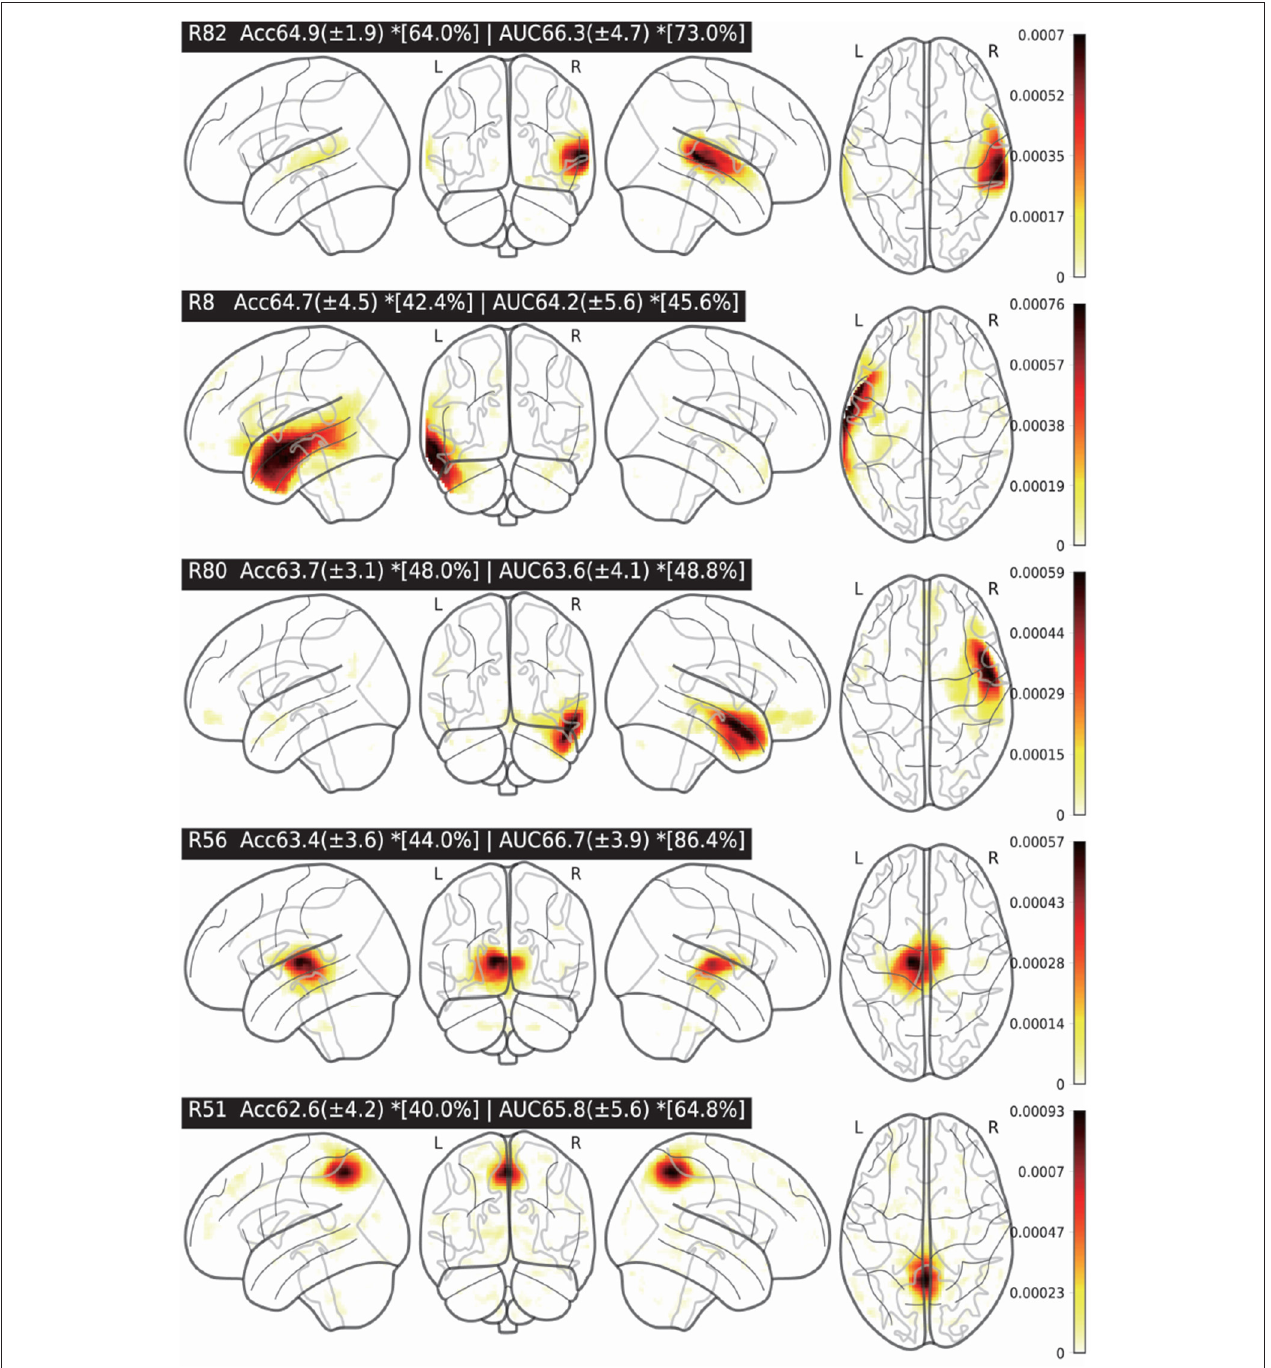
FIGURE 5 | Five most discriminative brain regions and the classification averaged accuracy (ACC)/area under the curve (AUC) ( ± SD). The ∗ [ x % ] of each region indicates that its ACC/AUC is significantly higher than that of the rest x % regions ( t -test p < 0.05).